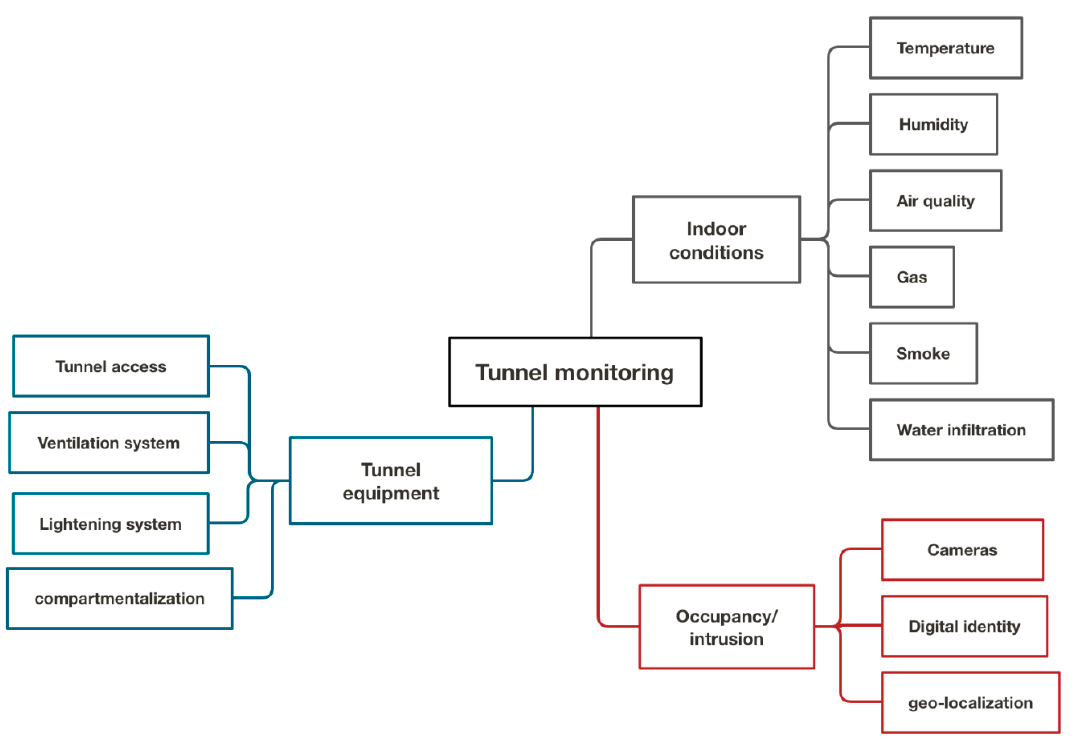
Figure 5. Tunnel smart monitoring.